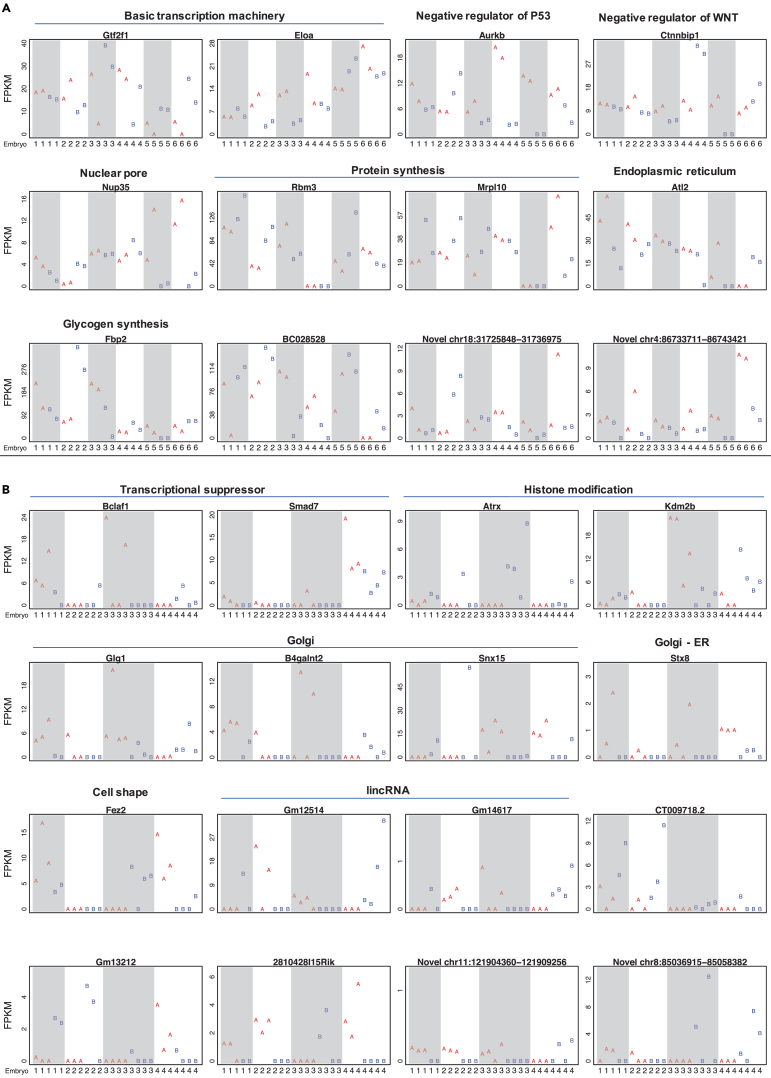
Genes with differential expression between two lineages.Genes with the between-lineage differences at 4- (A) and 8-cell (B) stages. FPKM (y axis) of every blastomere (column) in each embryo (marked by embryo number in columns). Shaded columns delineate different embryos. The blastomeres of the two lineages are marked with A (red) and B (blue).